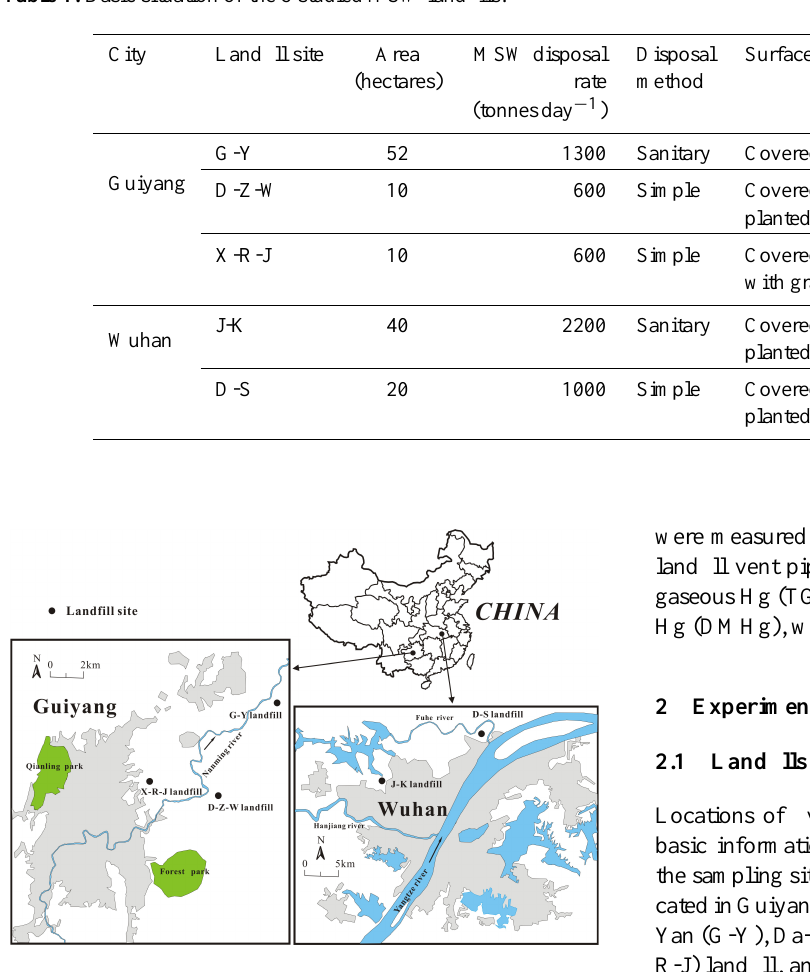
Fig. 1. Sketch map showing the locality of five studied